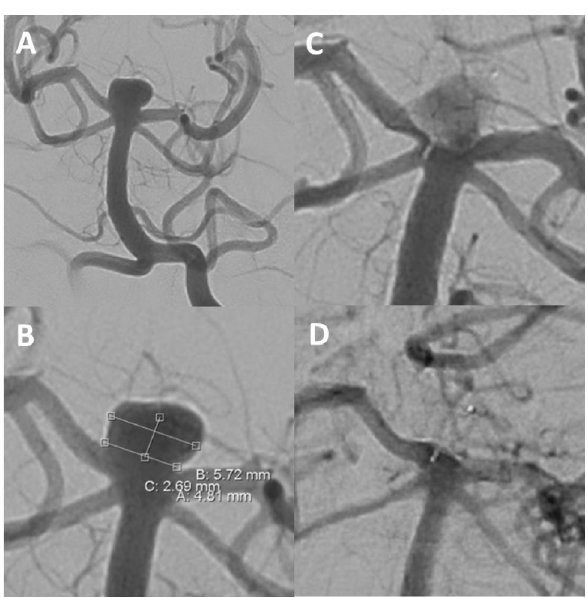
Figure 3. Unruptured aneurysm at the basilar tip ( A + B ). Due to the broad-based geometry and the unruptured aneurysm status, intrasaccular flow-disruption was envisaged. A WEB SL (7 × 3 mm) was placed within the aneurysm sac, achieving immediate contrast stasis ( C ). Two-years angiographic control shows complete aneurysm occlusion ( D